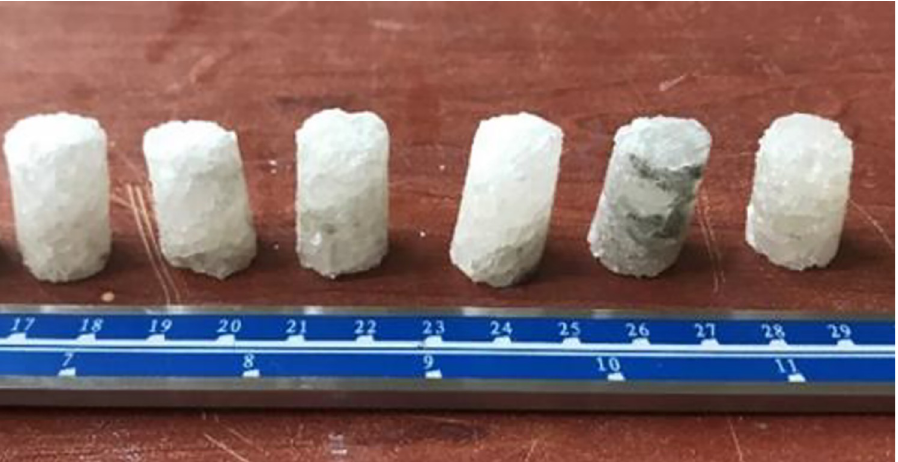
Fig 4. Samples used in X-ray micro computed tomography.